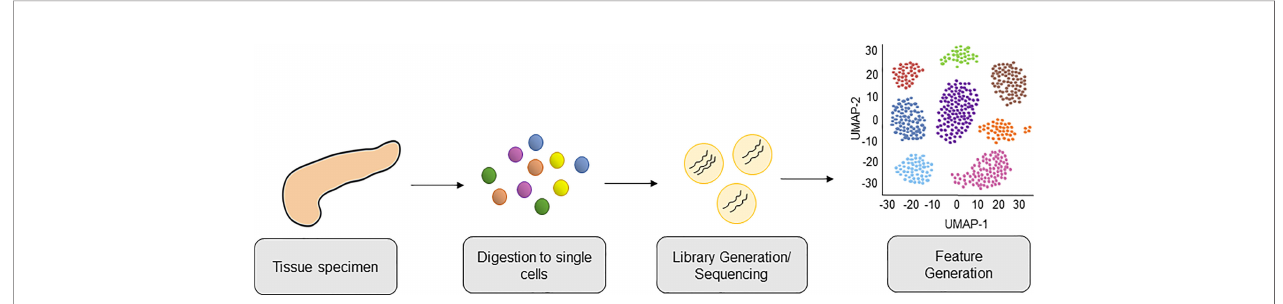
FIGURE 1 | Work fl ow of Single-Cell RNA-sequencing PDAC tissue from patients. PDAC tissue is collected from patient donors and digested into a single cell suspension of live cells. Cells are lysed, cellular mRNA captured, and cDNA libraries are generated and subjected to high-throughput sequencing. This is followed by bioinformatics analysis, including downstream feature generation and visualization of cells clusters by Uniform Manifold Approximation and Projection